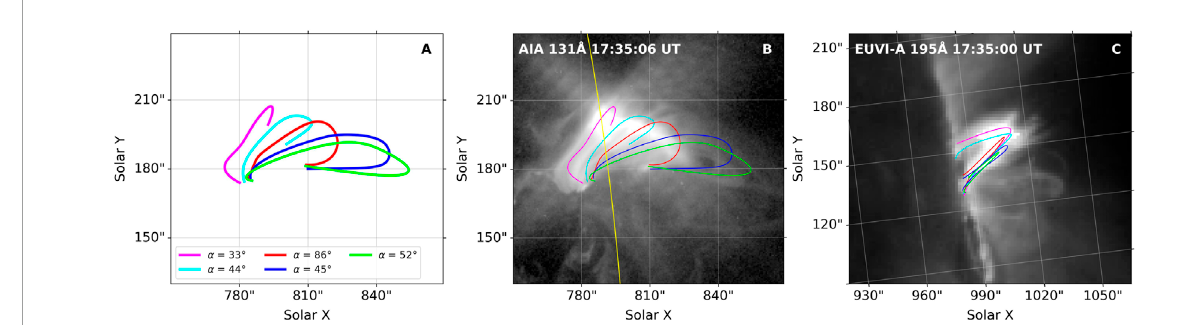
FIGURE 7 Flare loops traced using stereoscopic observations of the flare arcade from the AIA 131Å and EUVI 195Å during the impulsive phase of the flare. Panel (A) shows these loops plotted in a blank image and lists the viewing angles α of these loops. Panels (B) and (C) show the loops replotted atop of snapshots from AIA and EUVI. The yellow line plotted in panel (B) indicates the location of the solar limb from the observing point of the STEREO-A